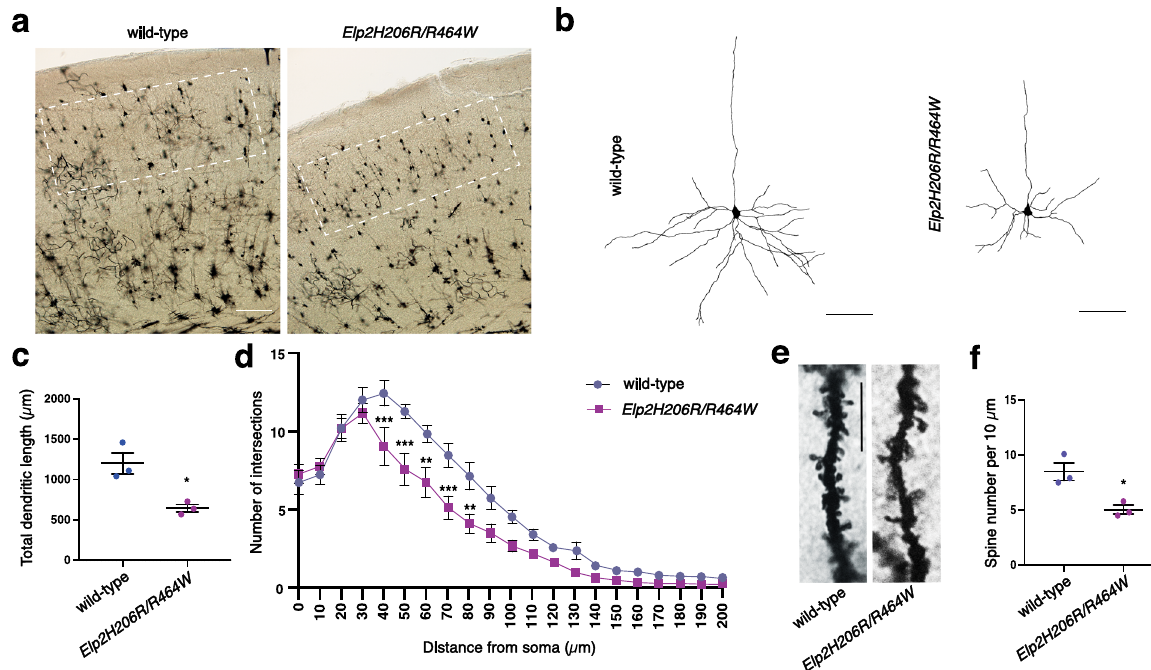
Fig. 6 Morphological abnormalities of cortical neurons in Elp2 mutant mice. a Golgi-Cox-stained coronal sections in the area of the somatosensory cortex of adult (2-months-old) wild-type and Elp2H206R/R464W mice. White rectangles highlight pyramidal neurons from cortical layers II and III selected for neuron reconstruction and subsequent analyses. b Representative pyramidal neuron reconstructions are depicted (basal dendritic trees were reconstructed). c Quanti fi cation of total dendritic length from dendritic tree reconstructions shown in ( b ). n = 15, 5 neurons per animal and 3 animals per genotype. d Sholl analysis of the complexity of basal dendritic arbors. e Representative images of dendritic spines on basal dendrites of the cortical neurons shown in ( a ). f Spine density per 10 μ m was measured on secondary dendrites. For ( d ) and ( f ) n = 30, 10 neurons per animal and 3 animals per